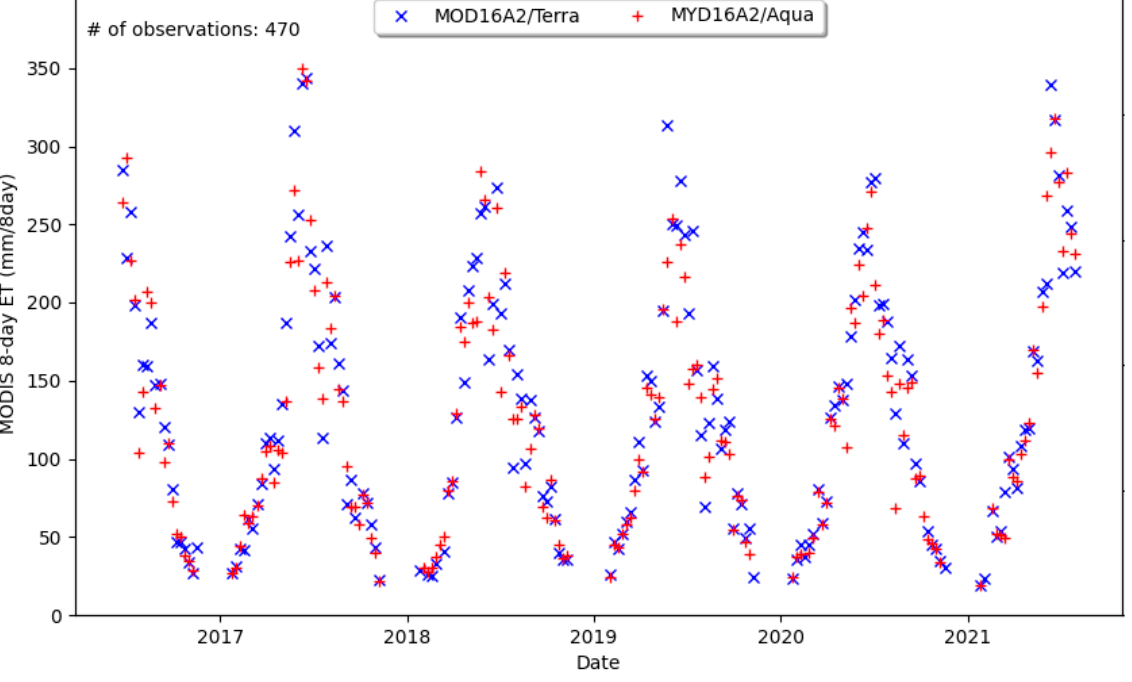
Figure 3. Terra/Aqua MODIS evapotranspiration (mm/8 day) time series for the coniferous forested area surrounding the “Burkersdorf” weather station.